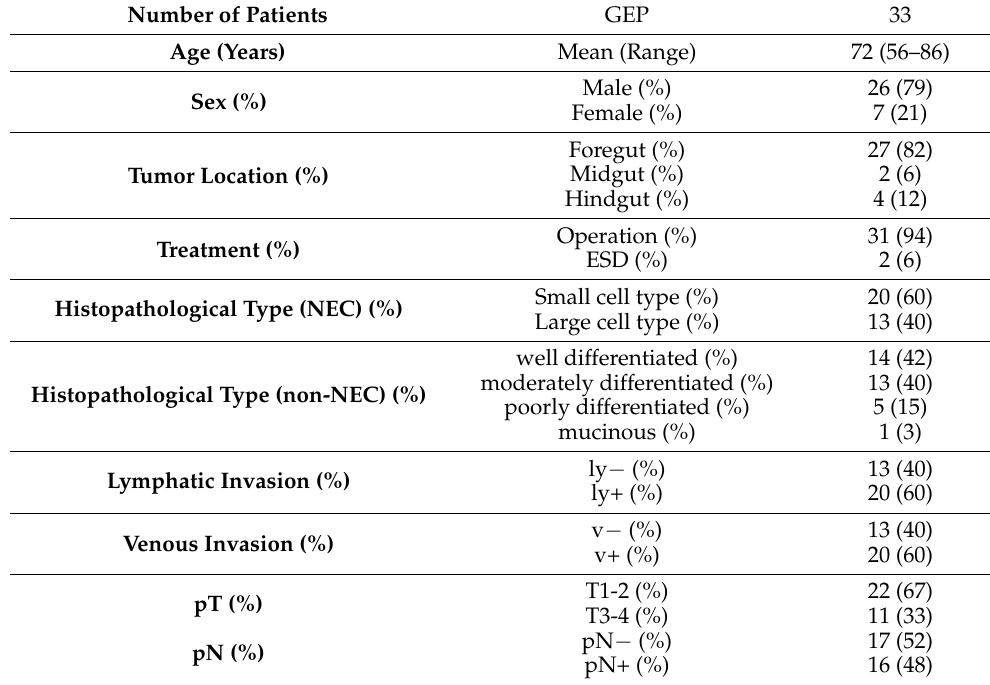
Table 1. Summary of the clinicopathological characteristics of the patients with mixed neuroendocrine non-neuroendocrine neoplasm in this study.